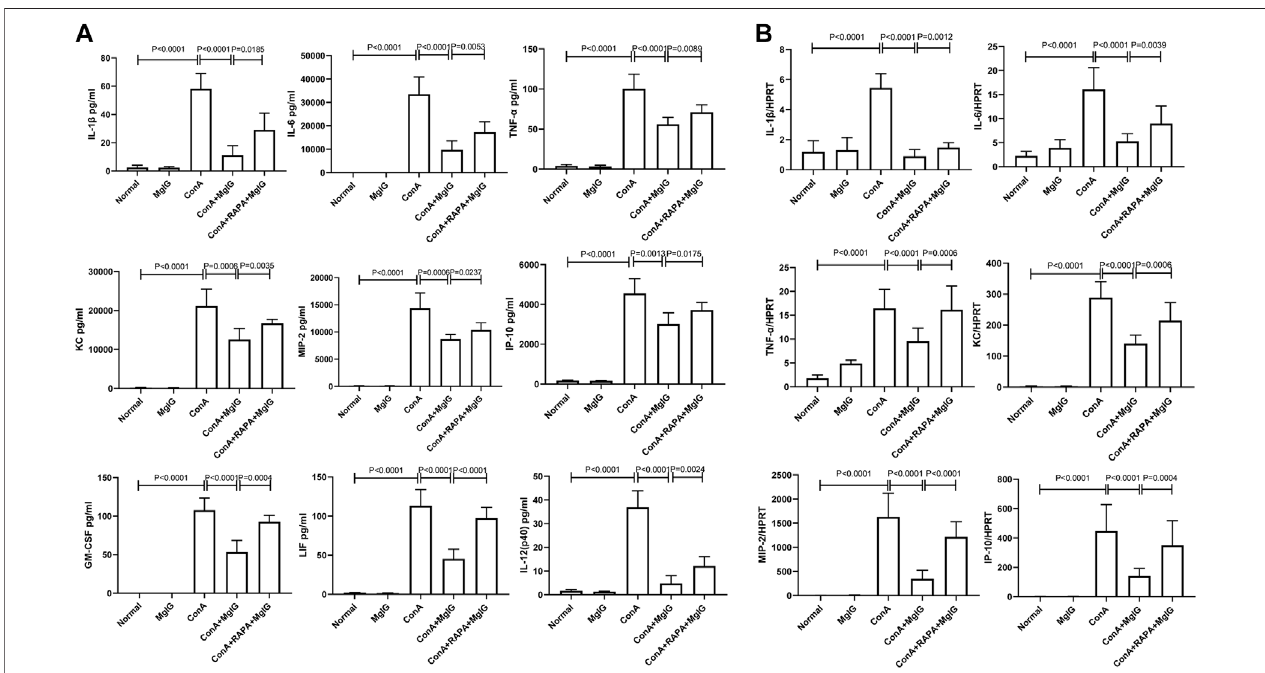
FIGURE 3 | MgIG regulates cytokine levels in the serum and cytokine transcript levels in liver tissues in ConA-induced liver injury. The data are shown as the mean and SD of at least three independent experiments. (A) Measurement of cytokine levels in the sera of mice in each model group by the Luminex Milliplex ® MAP Kit (IL-1 β , IL-6, TNF- α , KC, MIP-2, IP-10, GM-CSF, LIF, IL-12). (B) Analysis of the gene expression levels of cytokines (IL-1 β , IL-6, TNF- α , KC, MIP-2, IP-10) in liver tissues from each group by